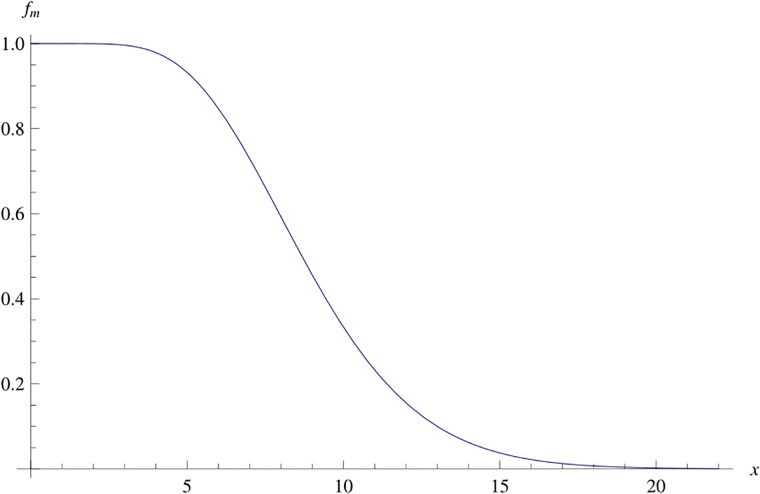
Graph of fm(x) for m = 9.